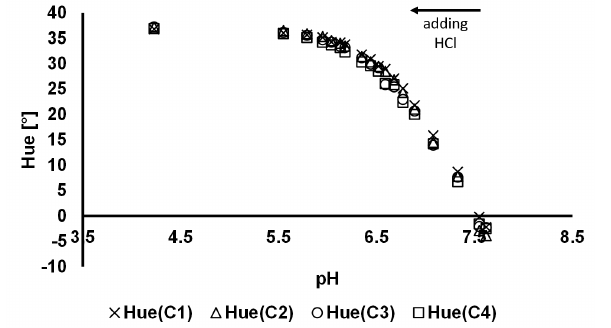
Figure 11. Hue data (mean value of 10 measurements) of non- diluted nutrition media as a function of pH values measured in four different chambers at